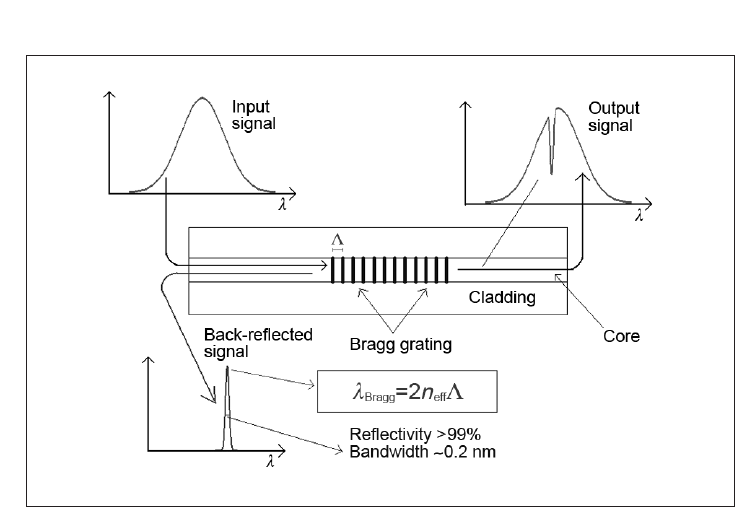
Fig. 1. Fiber Bragg grating reflection and transmission properties.